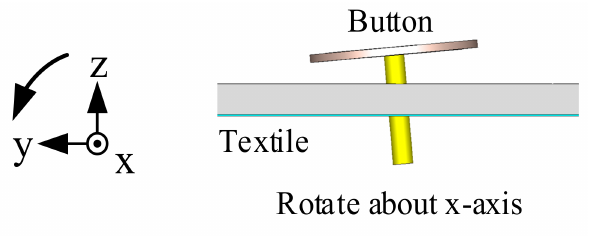
Figure 17. Rotating about the x